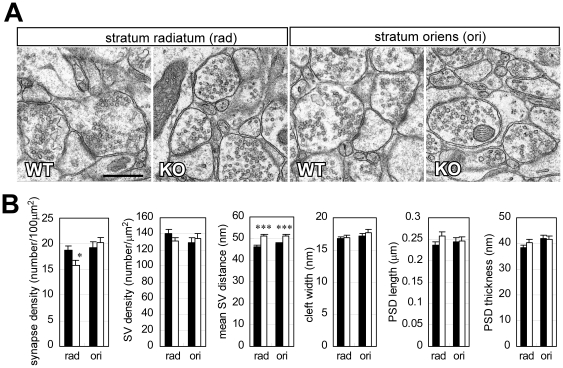
Electron microscopic analysis of hippocampal synapses.(A) Representative images of stratum radiatum and stratum oriens synapses. Scale bar, 500 nm. (B) Quantification of synapse number in 100 µm2 of the entire images (synapse density), number of synaptic vesicles in 1 µm2 of presynaptic bouton region (SV density), distance between synaptic vesicles (mean SV distance), cleft width, and postsynaptic density (PSD) width (length) and thickness. One hundred and thirty-three synapses from 3 KO mice and 126 synapses from 3 WT mice were analyzed. Black bars, WT; open bars, KO. Values are presented as means ±SEM. * P<0.05; *** P<0.001.